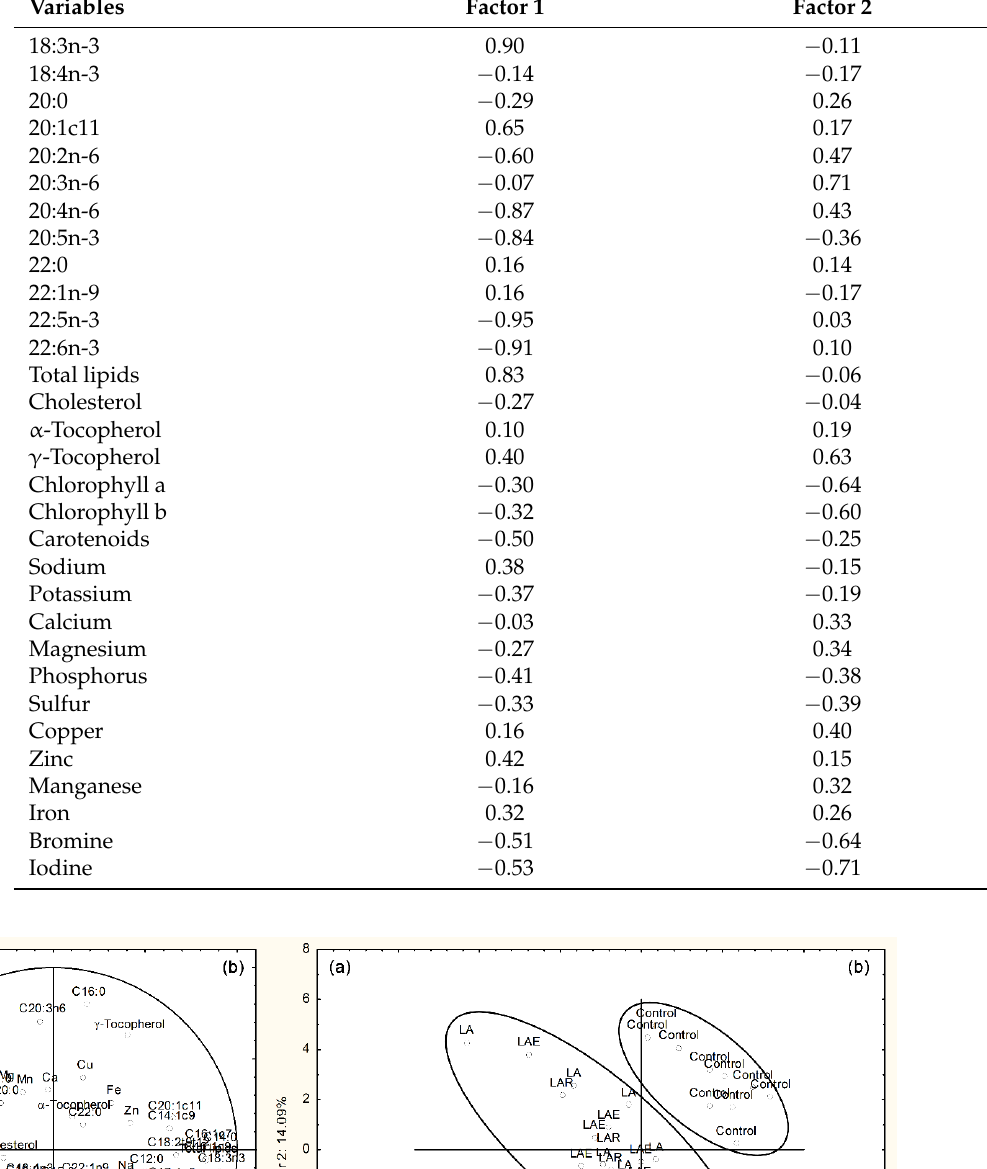
Table 11. Loadings for the first two principal components in the breast muscle.